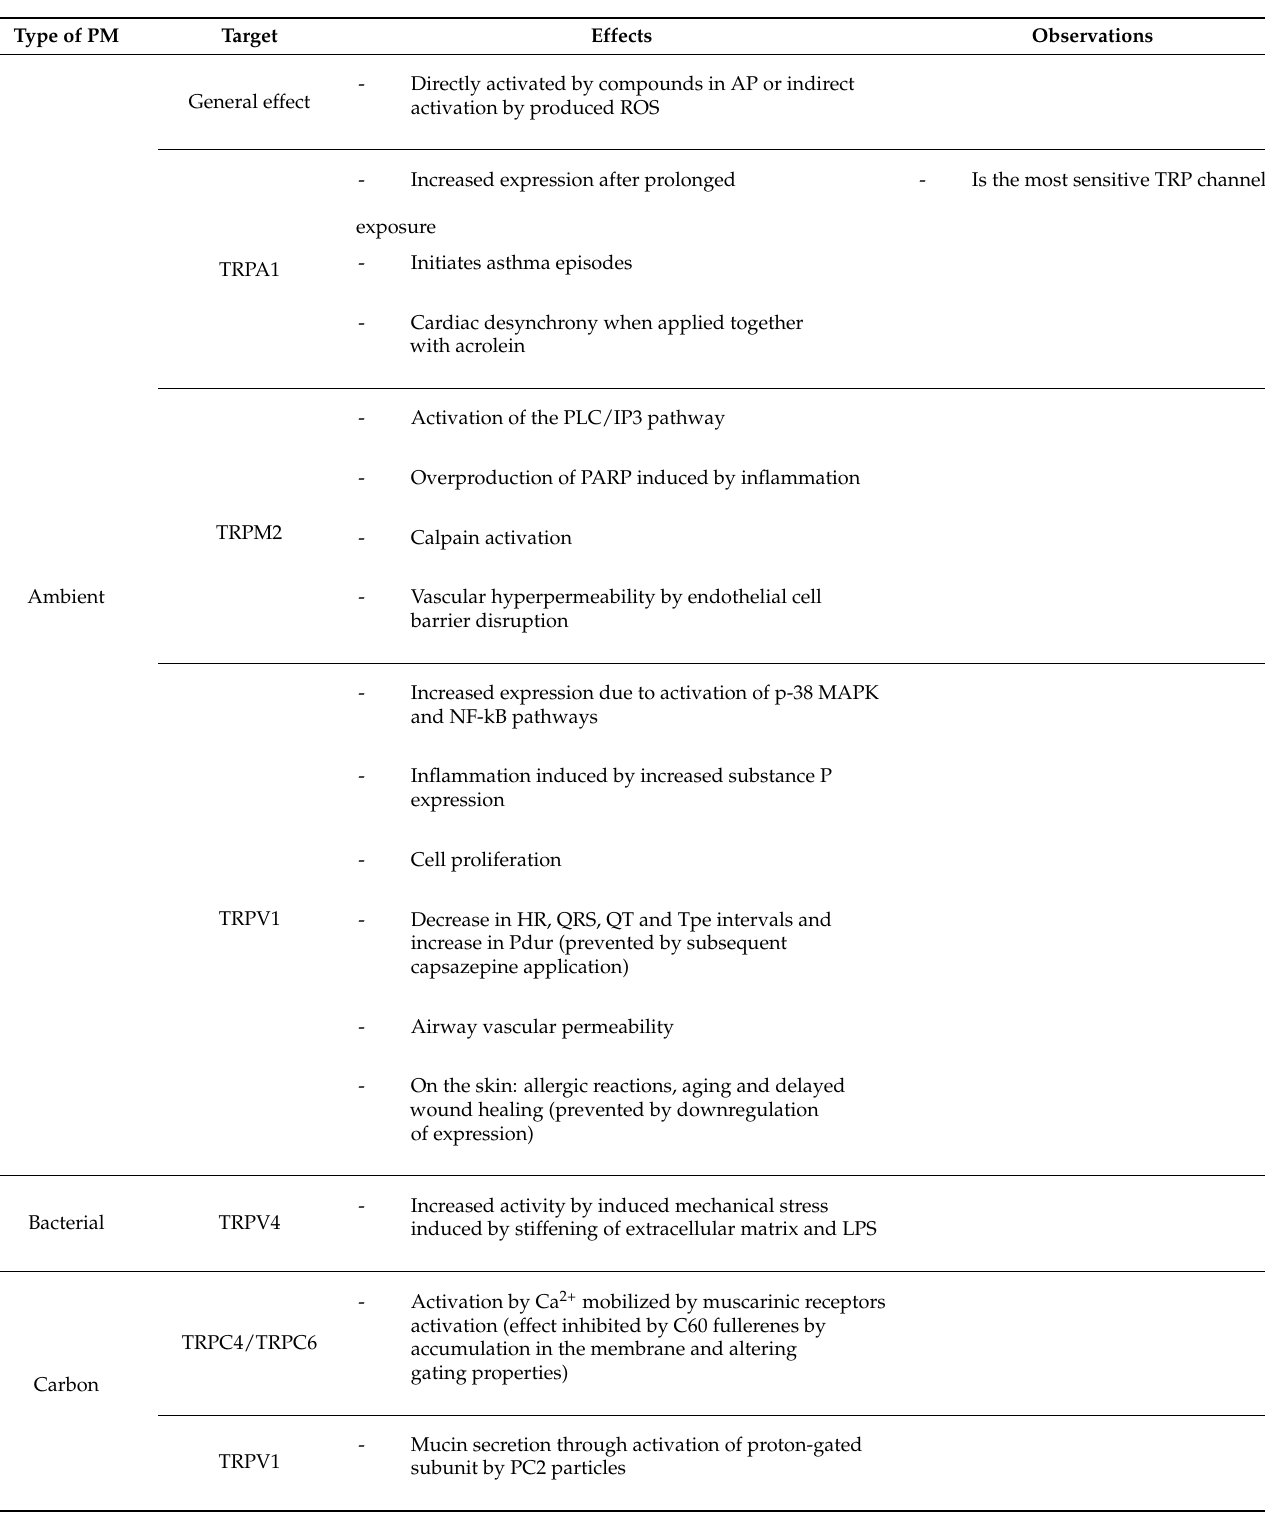
Table 1. Overview of TRP channels targeted by particulate